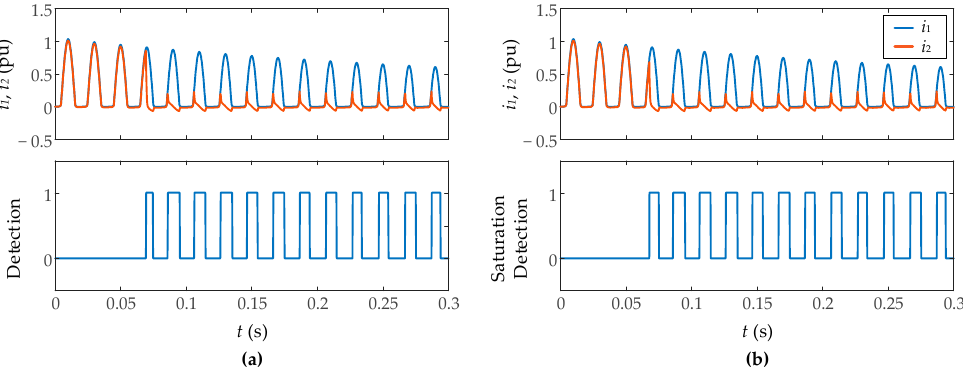
Figure 14. Performance of proposed algorithm against Gaussian noise. Signal to noise ratio: ( a ) 35 dB, ( b ) 50 dB, ( c ) 35 dB, ( d ) 50 dB.